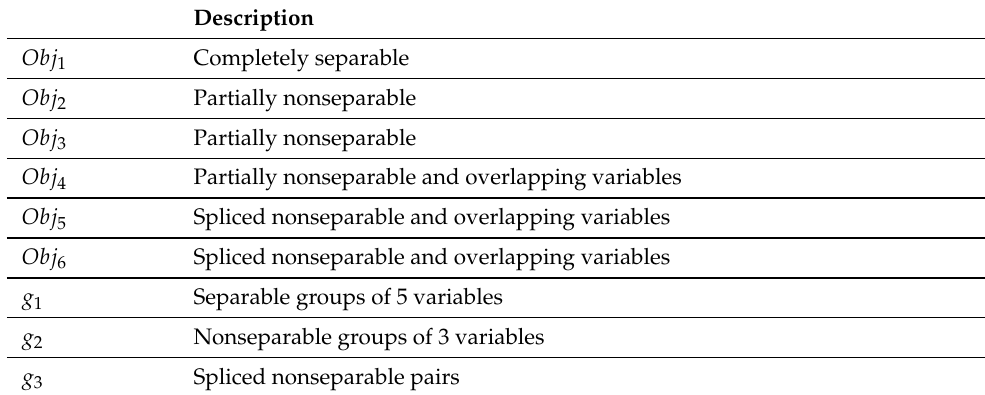
Table 1. Characteristics of the objective functions and